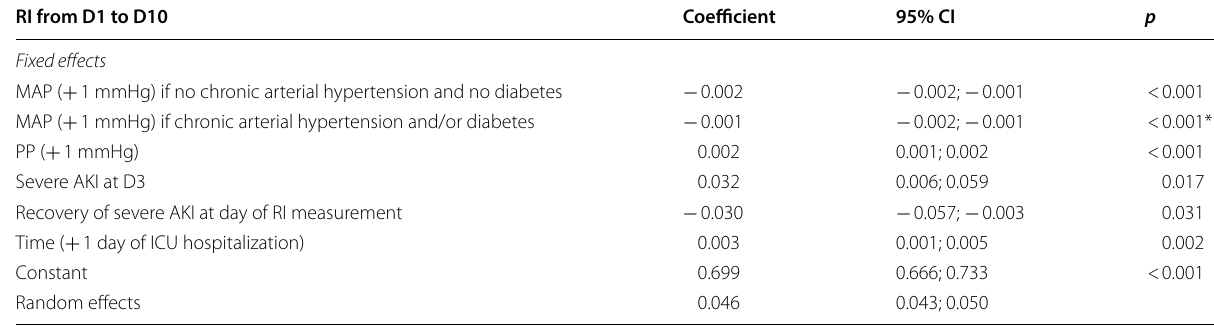
All the continuous covariates, the coefficient associated with the considered covariate corresponds to the impact on renal resistive index of the increase of one unit in this covariate MAP mean arterial pressure, PP pulse pressure, AKI acute kidney injury, ICU intensive care unit, Severe AKI acute kidney injury acute kidney injury network 2 or 3 *Interaction between MAP and chronic arterial hypertension and/or diabetes, p